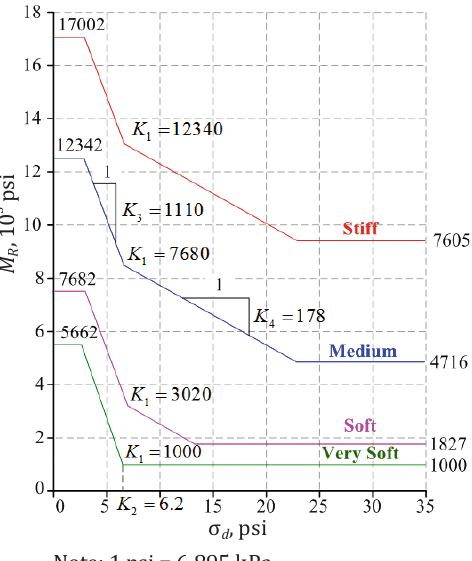
Figure 3. The relationship between the resilient modulus and the deviatoric stress for the four soil types (Thompson & Robnett,